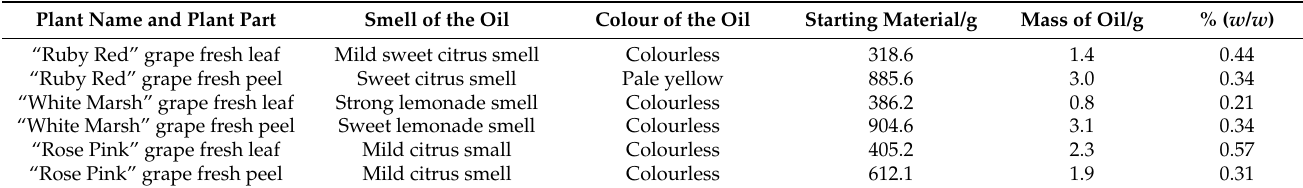
Table 1. Physiochemical analysis of the essential oils from three Citrus paradisi varieties.